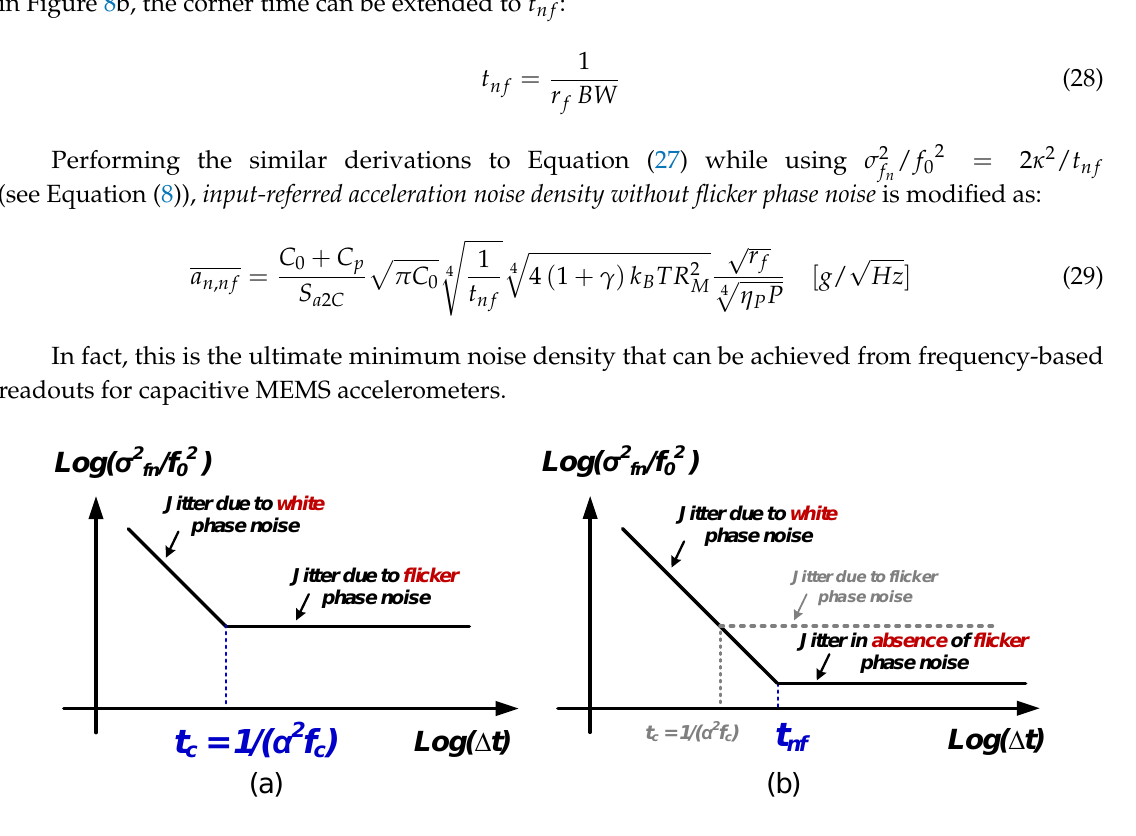
/ f 02 ) with an increase f n (cid:0) (cid:1) α 2 f c [24,52]; ( b ) the corner time is extended